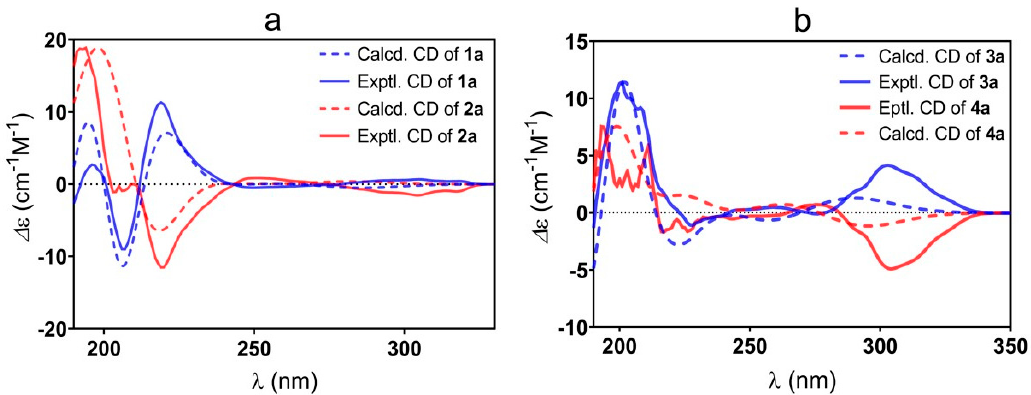
Figure 1. Experimental and calculated ECD spectra of 1a and 2a ( a ), 3a , and 4a ( b ).